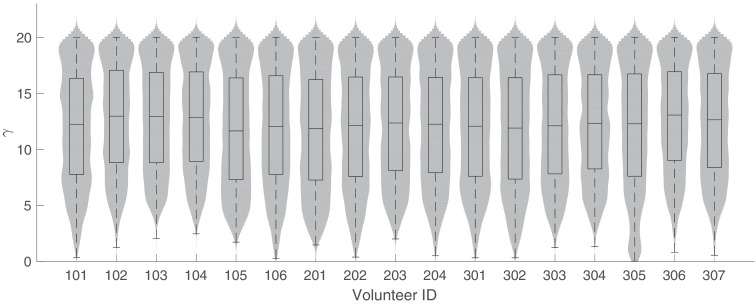
The marginal posterior distributions of the individual parameter of γ (Hill coefficient for PQP) for all 17 volunteers.The violin plots (gray area) show the distributions of 5000 posterior samples. Box plots show the 25%, 50% (median) and 75% quantiles with outliers indicated by red dots. Relevant details of the individual parameter are provided in the Materials and methods in the main text.